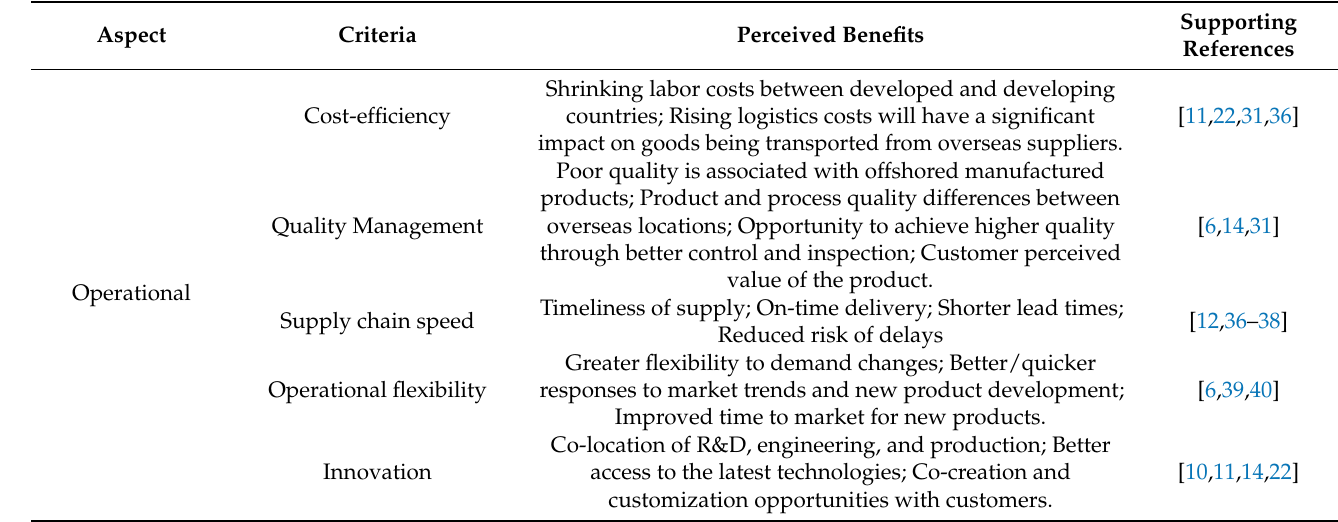
Table 1. Criteria for reshoring